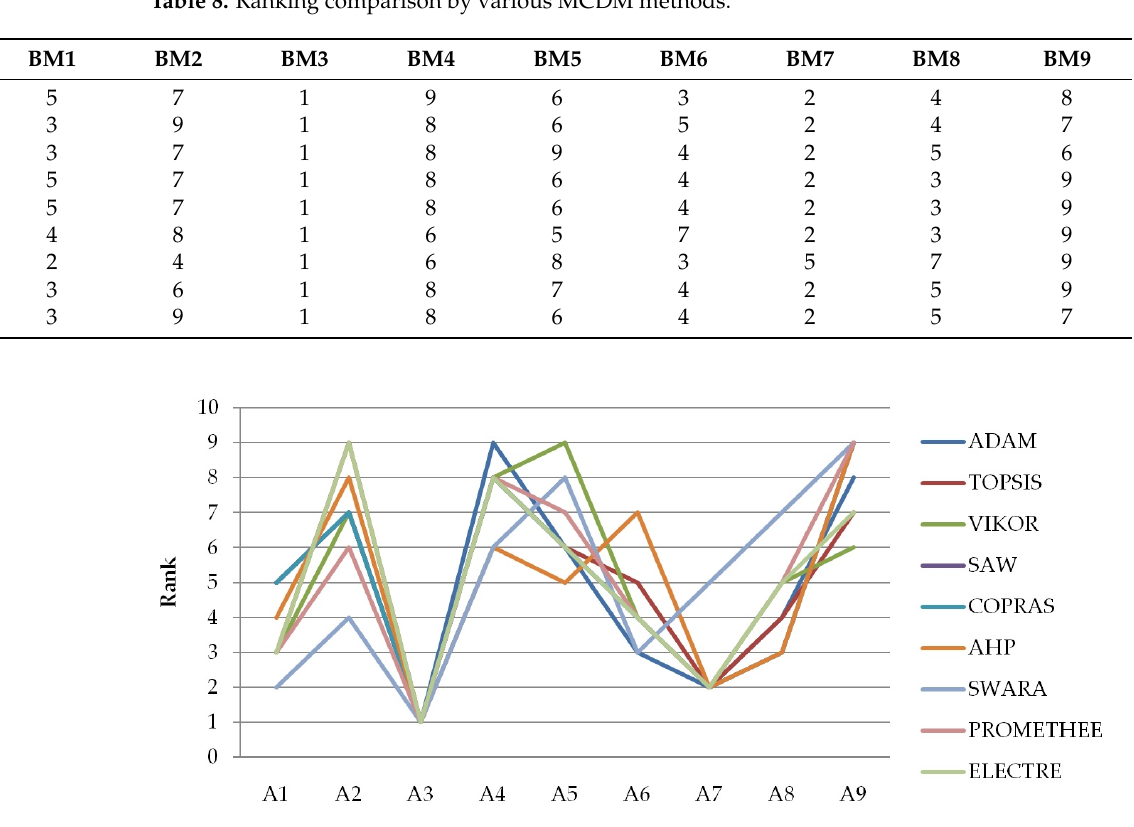
Table 9. SCC values of method comparisons.